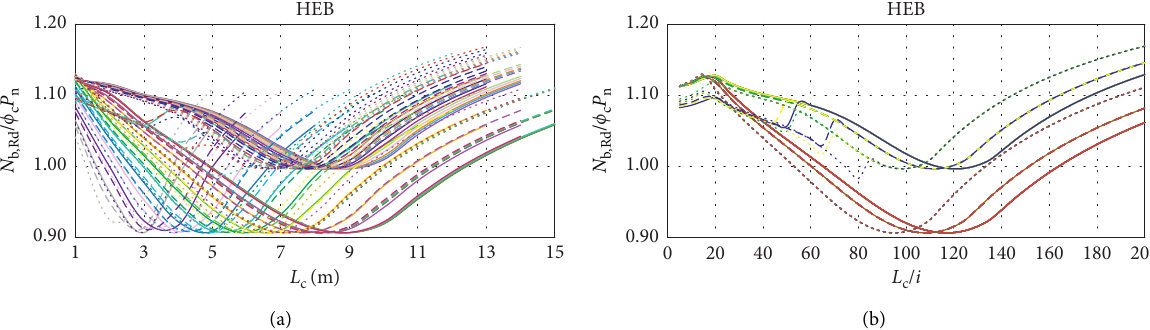
Figure 11: Variation of capacity ratio with buckling length L c (a) and with member slenderness L c / i (b) for studied HEB members. In each plot, the solid, dashed, and dotted curves with identical colours represent the capacity curves plotted for a particular section when the steel grades are S235, S275, and S355,